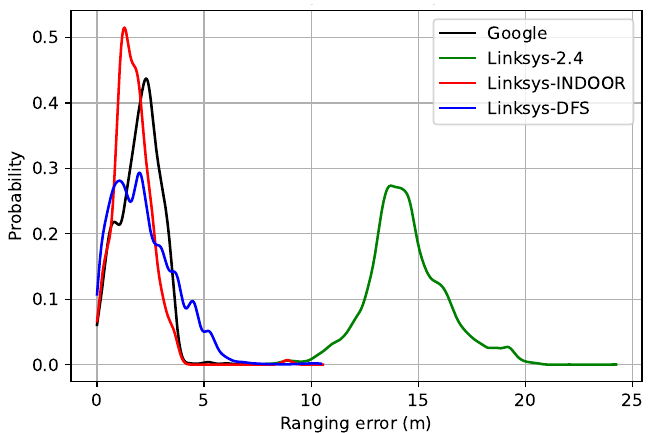
Figure 7. PDF of the ranging